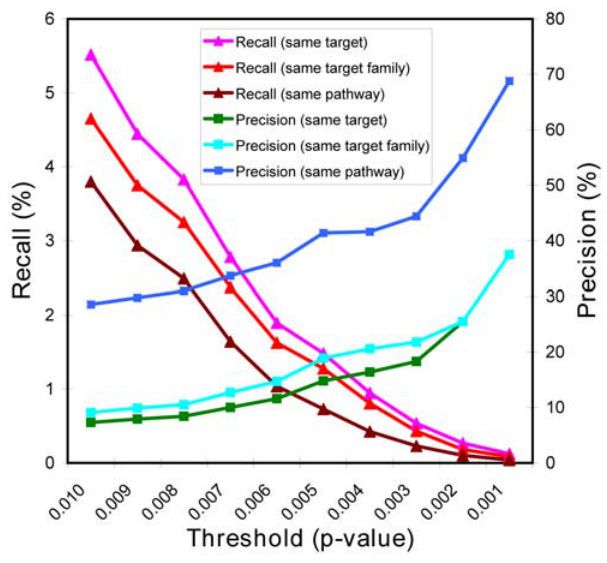
Figure 3. The precision and recall of target and pathway deconvolution. Precision is the fraction of the identified targets or pathways that are correct, calculated as ‘‘true positive’’/(‘‘true positive’’ + ‘‘false positive’’). Recall is the fraction of all true targets or pathways that are successfully identified, calculated as ‘‘true positive’’/(‘‘true positive’’ + ‘‘false negative’’).